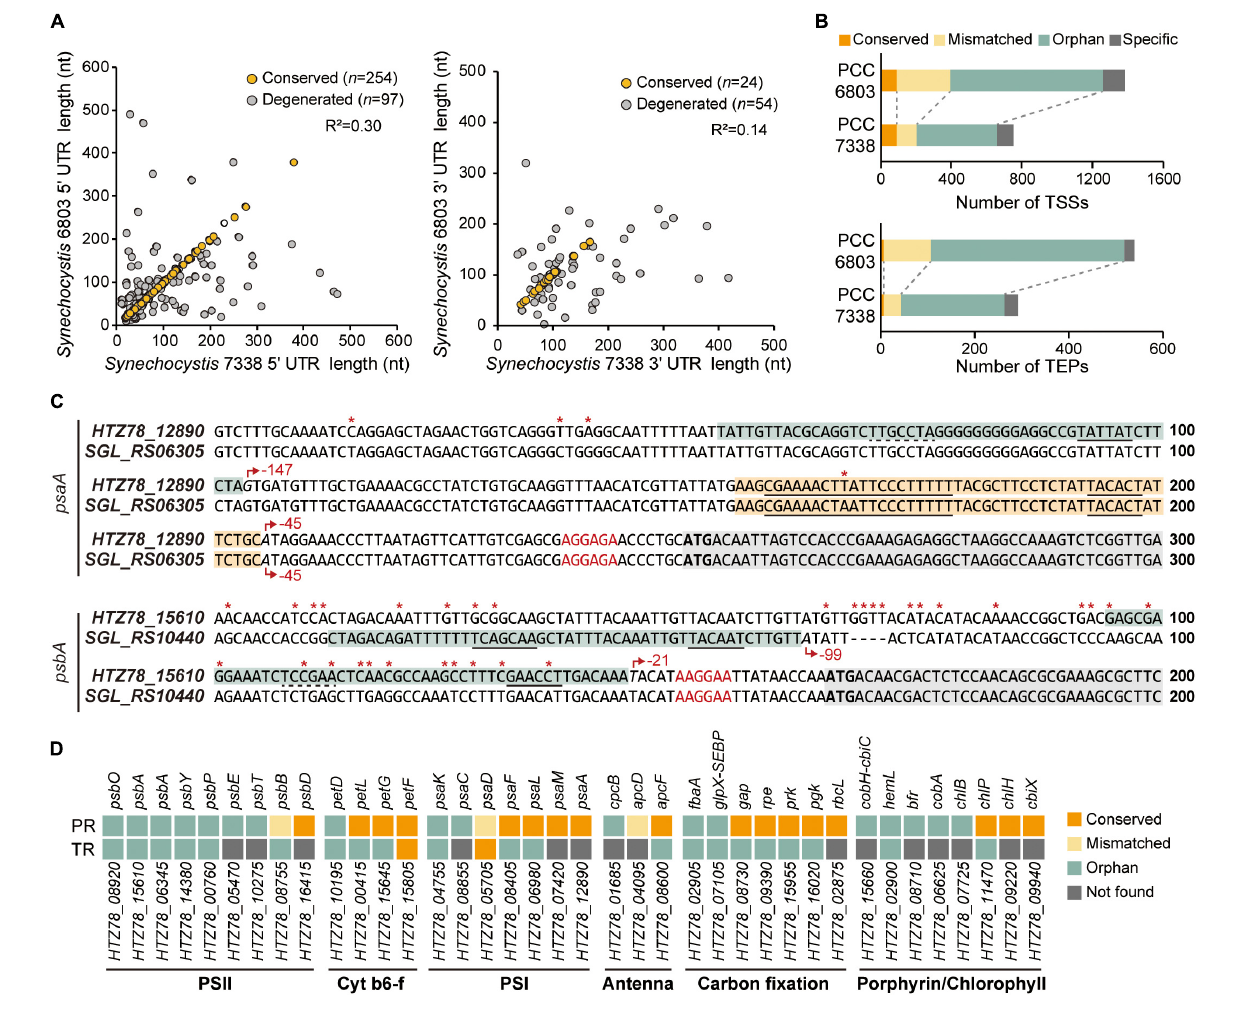
FIGURE 3 | Comparison of the regulatory regions between Synechocystis sp. PCC 7338 and Synechocystis sp. PCC 6803. (A) The 5 (cid:48) -UTR and the 3 (cid:48) -UTR lengths of orthologs were compared with Synechocystis sp. PCC 6803. The UTR lengths were classified as conserved or degenerated according to the length difference between the two strains. (B) The promoter regions and the terminator regions were compared between the two species and classified as four categories. (C) Examples of the compared promoter regions. psaA has a conserved promoter region (orange boxes) and an orphan promoter region (cyan box), and psbA has orphan promoter regions (cyan boxes). Grey boxes indicate the coding sequences. Red asterisks indicate the varying sequences. Red arrows indicate the TSSs, and the relative positions of the TSSs to the start codons are designated near the red arrows. The promoter sequences detected from MEME search are underlined with solid lines, and the predicted promoter sequences are underlined with dotted lines. The RBS sequences are indicated as red characters, and the start codons are indicated as bold characters. (D) The classification of the regulatory regions associated with the genes related to photosynthesis. Keys: PR, promoter region; TR, terminator region, PSII, photosystem II; Cyt b6-f, cytochrome b6-f; PSI, photosystem